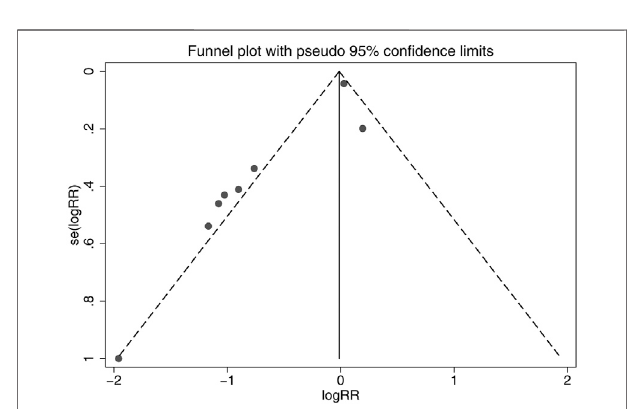
FIGURE8| Funnelplotsofdifferencesoftheincidenceofall-gradeCIPN in VE and control groups. VE, vitamin E; CIPN, chemotherapy-induced peripheral